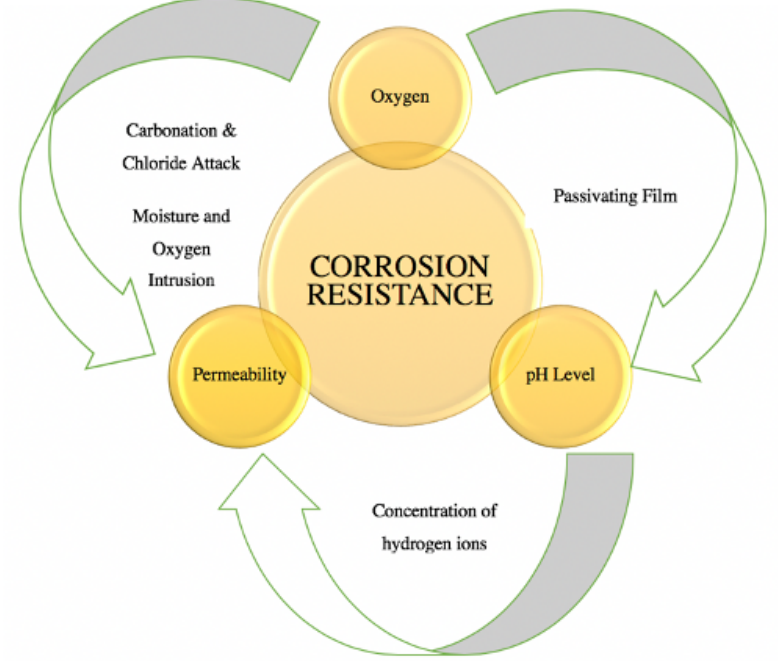
Figure 1. Graph showing relationship of Embodied Carbon for cements by clinker content, source [4]